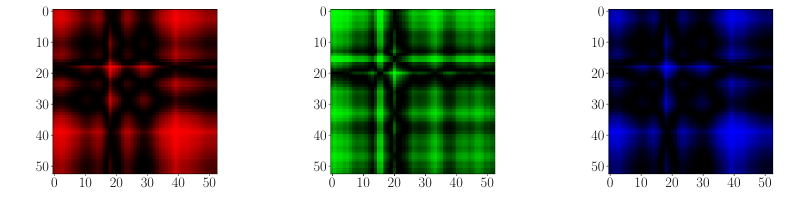
( c ) GAF of the magnitude vector of angular velocity.